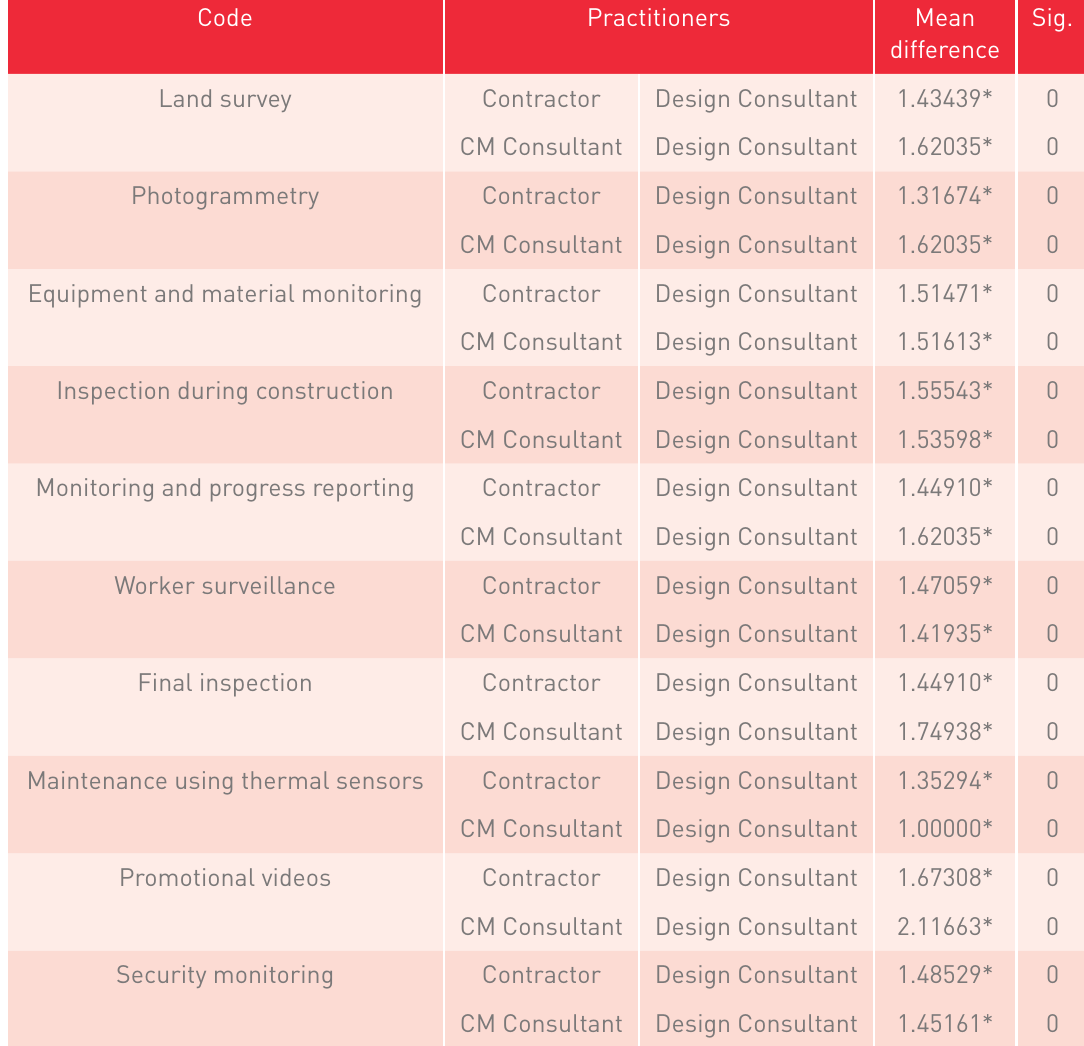
Games-Howell Post-hoc Test for the level of utilisation among construction practitioners